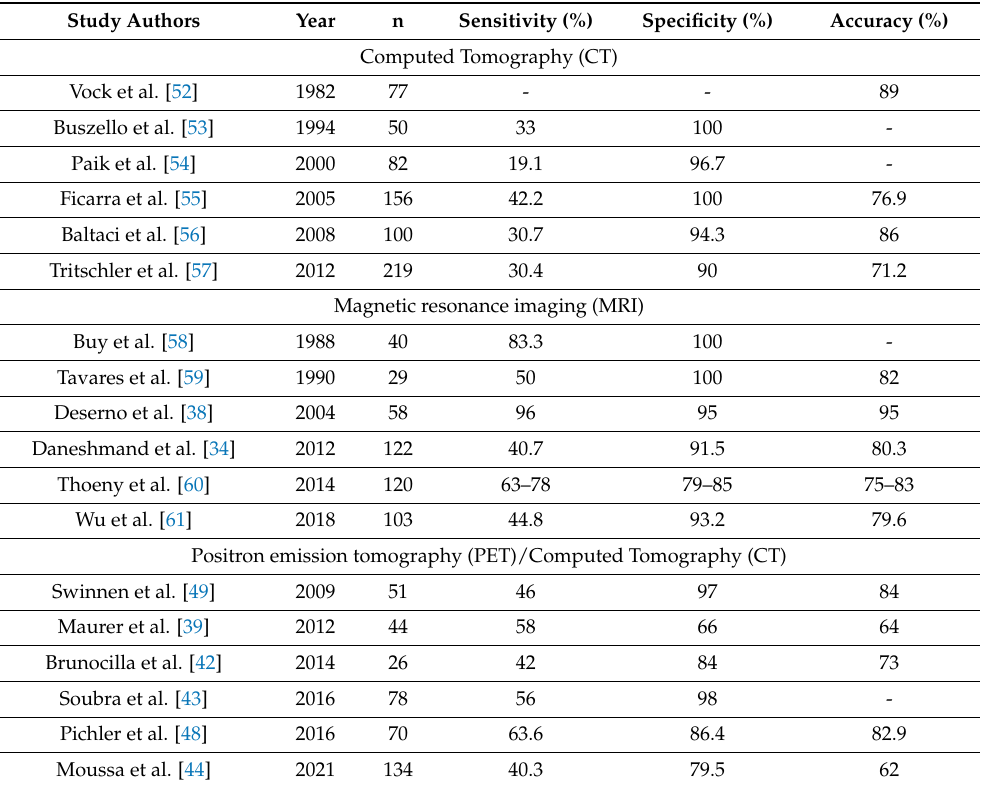
Table 1. Comparing CT, MRI, and PET/CT performance in preoperative prediction of LNI in BCa